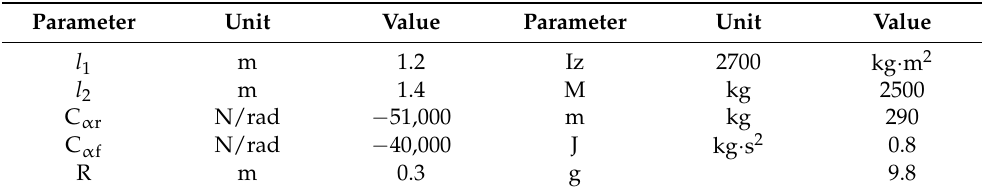
Table 2. Vehicle model parameters.